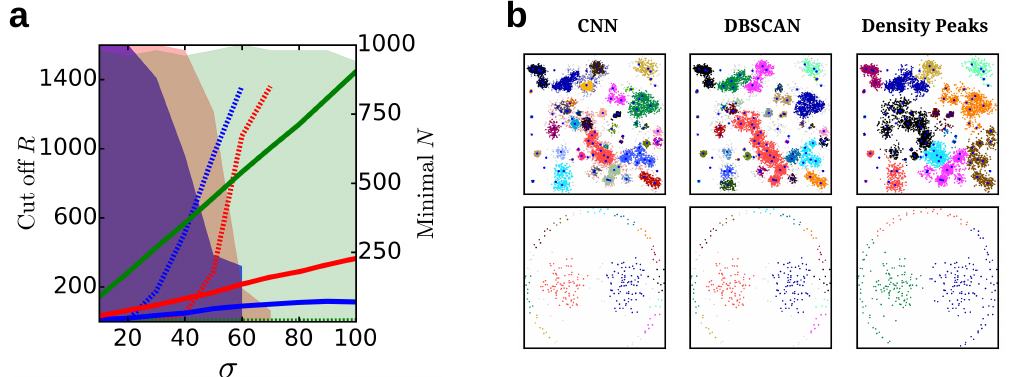
Figure 7. Further evaluation of the clustering: ( a ) Parameters R (solid, left axis) and N (dashed, right axis) for the clustering of the G2 datasets for 2 ( blue ), 8 ( red ) and 128 ( green ) dimensions. For N the minimal value is reported for which a split of the two clusters is observed. The colored region highlights the cluster sizes that are possible to extract. We note that beyond σ = 60 for two dimensions and σ = 70 for eight dimensions, no split of the clusters is observed. ( b ) Clustering for the Birch3 ( upper ) and the Path-based ( lower ) datasets using the common nearest neighbor (CNN), the DBSCAN and the density peaks